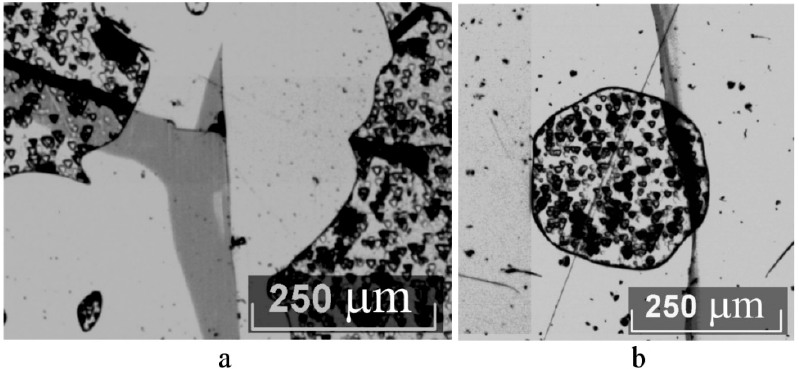
Figure A6. Crack formed in the crystal LiNbO 3 :Zn ([ZnO] ≈ 3.95 mol% in the crystal), Z-cut, at the interface between the matrix and the second phase with incoherent boundaries.